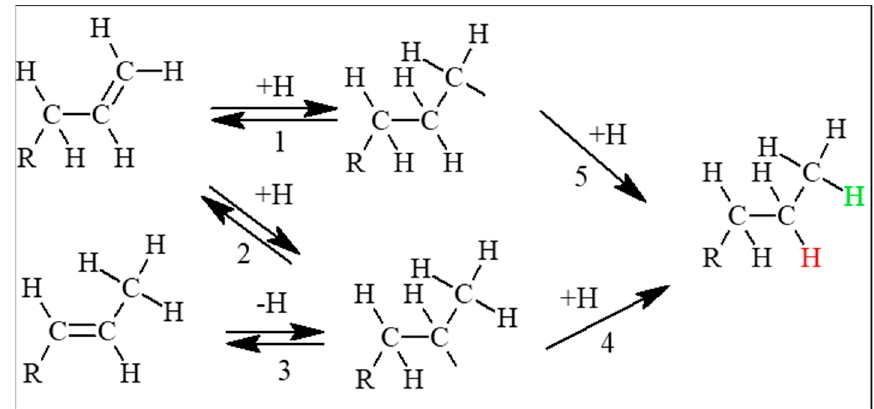
Figure 46. A redrawn mechanism taken from Shultz et al. [51] describing a possible route for the formation of the 2-olefins from the 1-olefin though reversible hydrogen